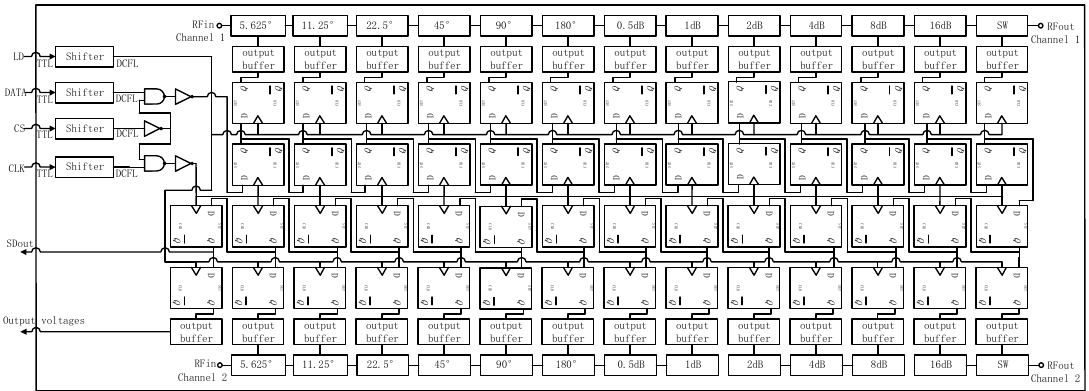
Figure 6. The schematic of the digital circuit.